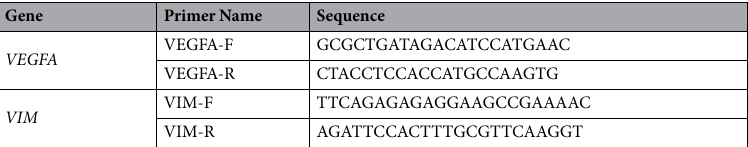
Table 4. Primer sequences for qPCR. All sequences are given in 5 ′ -3 ′ direction.